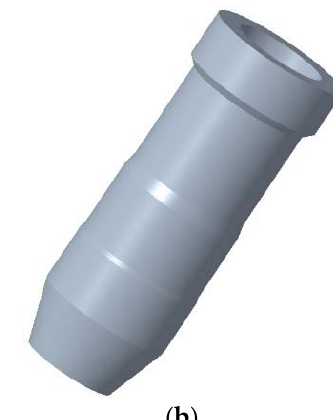
Figure 1. Cup with curved rotary profile: ( a ) schematic diagram; ( b ) 3D model.